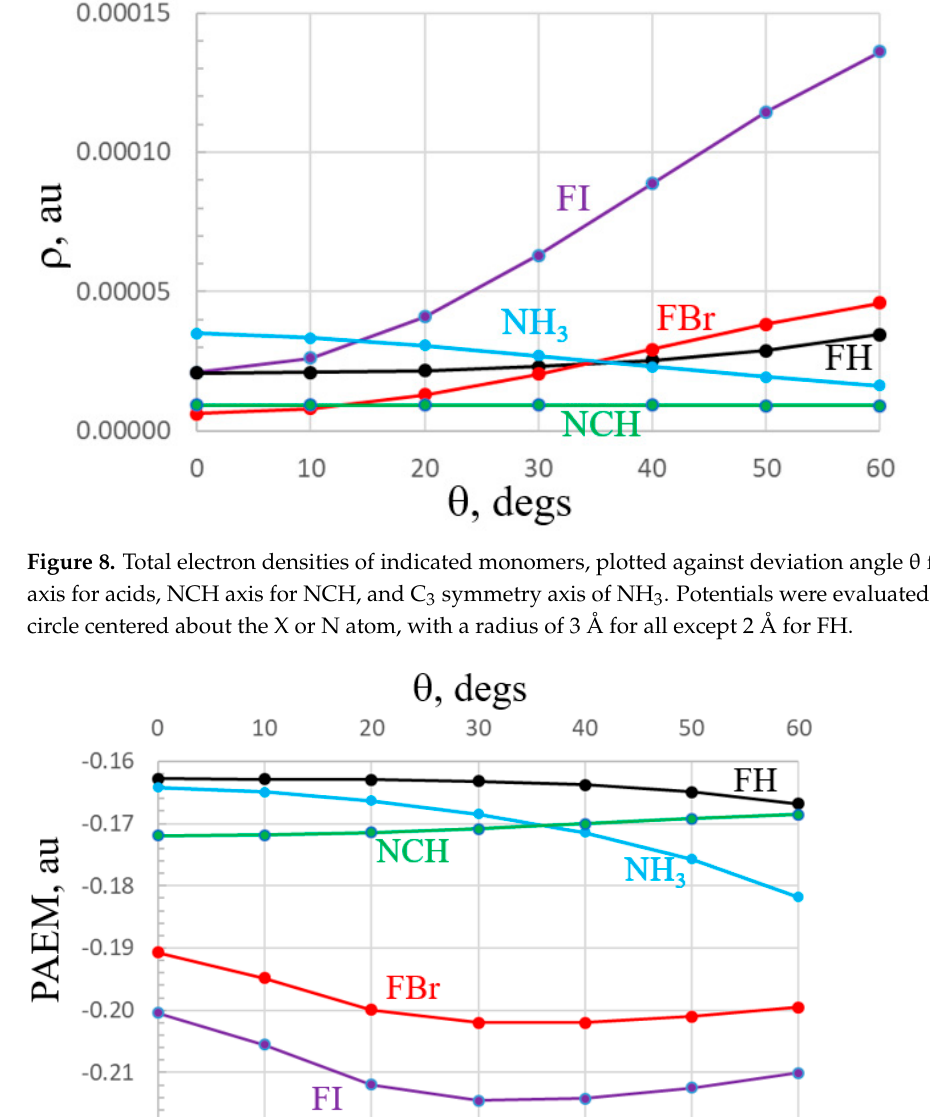
Figure 8. Total electron densities of indicated monomers, plotted against deviation angle θ from FX axis for acids, NCH axis for NCH, and C 3 symmetry axis of NH 3 . Potentials were evaluated